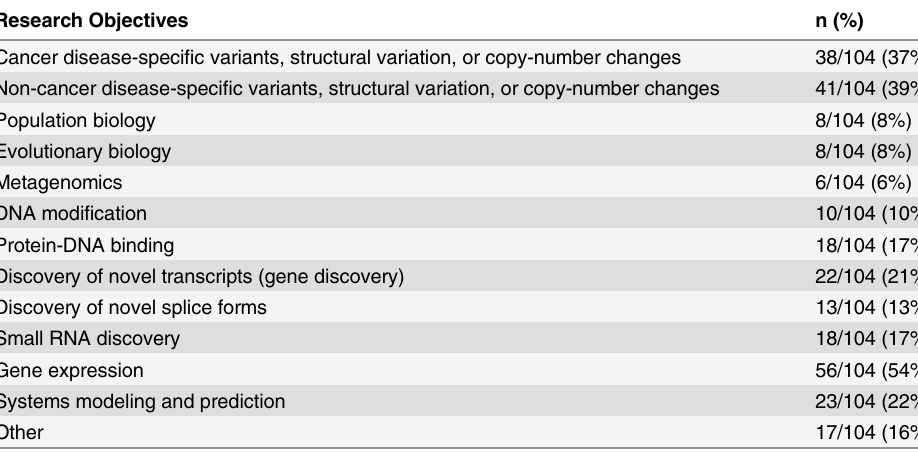
Table 4. Research objectives of survey respondents ( All Users